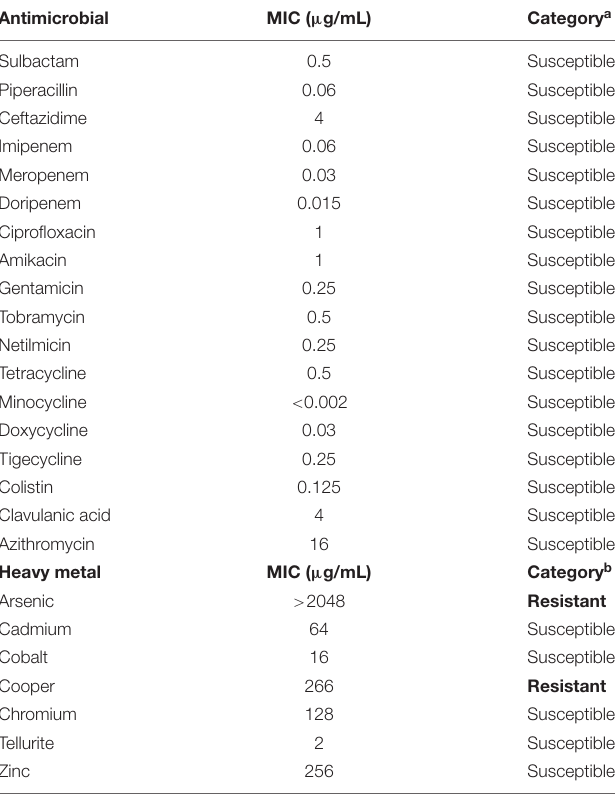
TABLE 1 | Minimal inhibitory concentrations (MICs) of several antibiotics and heavy metals for Acinetobacter sp. strain 5-2Ac02.